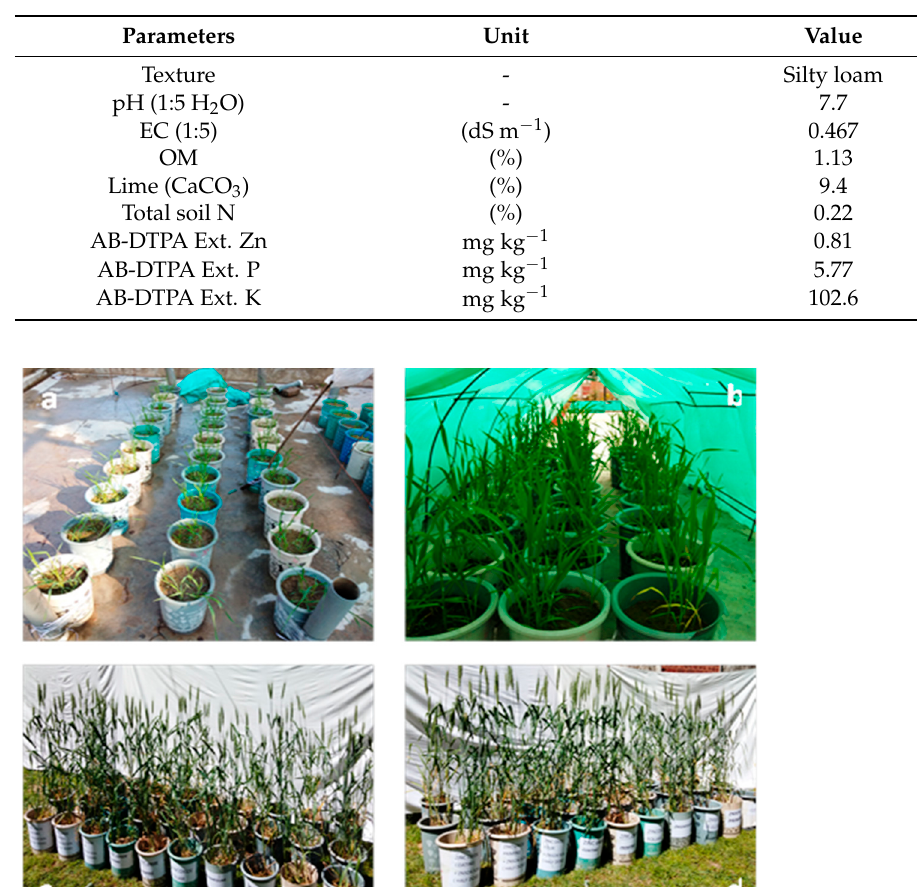
Table 1. Pre-sowing characteristics of the soil used in the experiment.